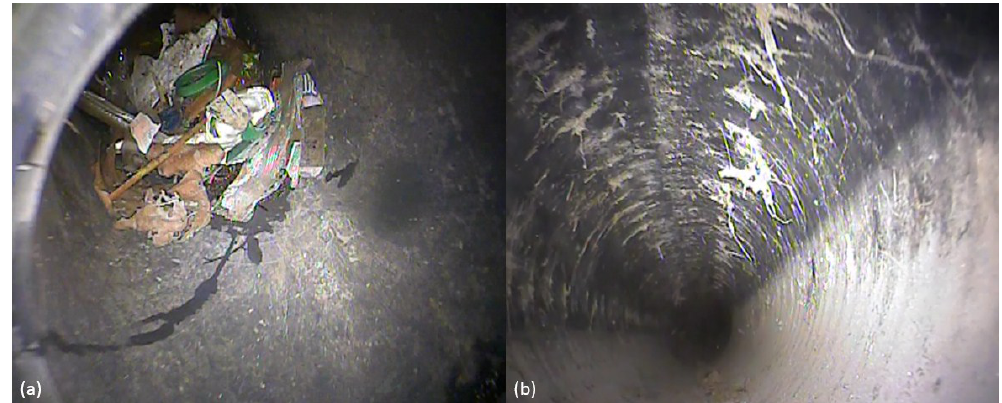
Figure 12. Images of debris deposition conditions before subsurface cleaning (Date: 20 June 2016). ( a ) debris observed at the lower end of the pipe; ( b ) typical pipe condition above the lower end.